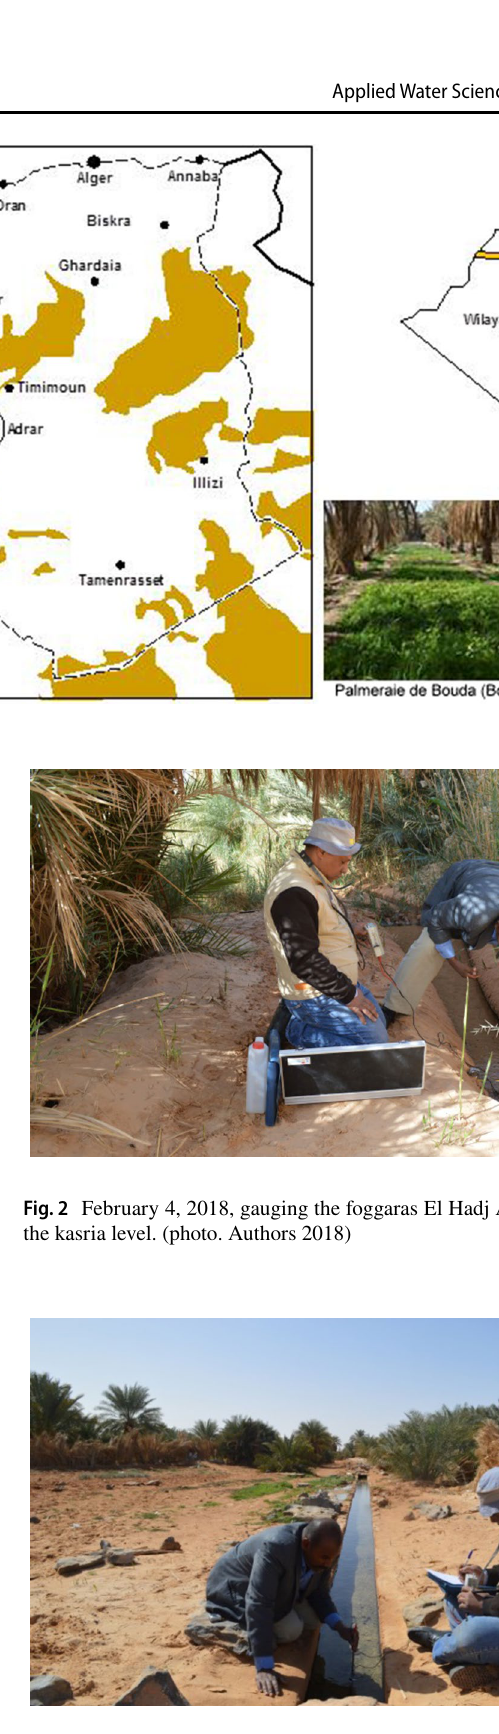
Fig. 3 February 07, 2018, gauging of the foggara of Bouzid at the level of the main canal. (photo. Authors